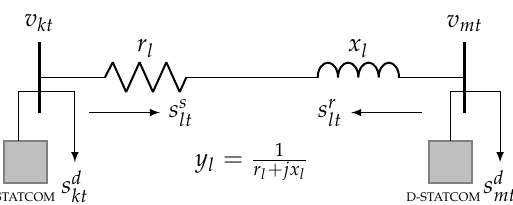
Figure 1. Generic branch scheme for an electrical distribution